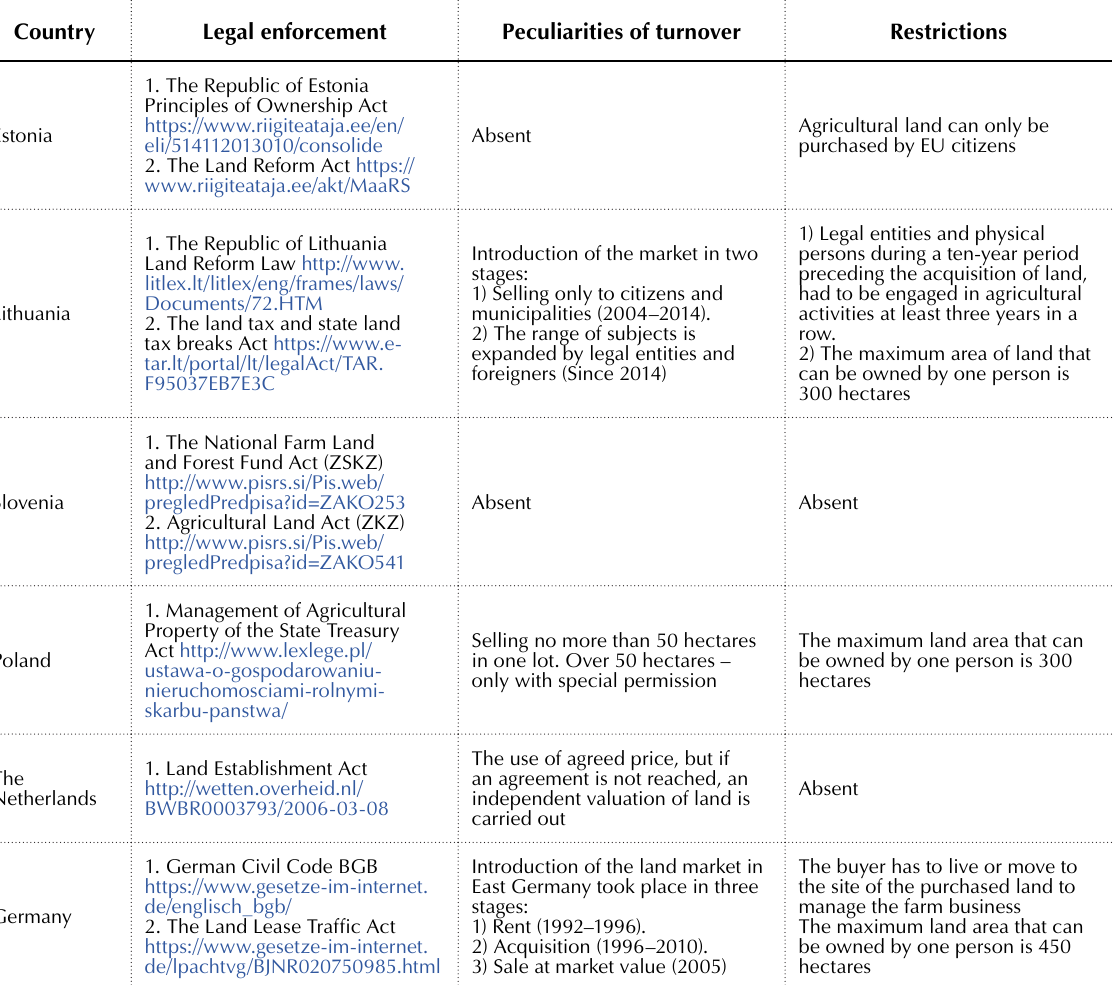
Table 4. Models of introduction of the land market in some countries of the European Union